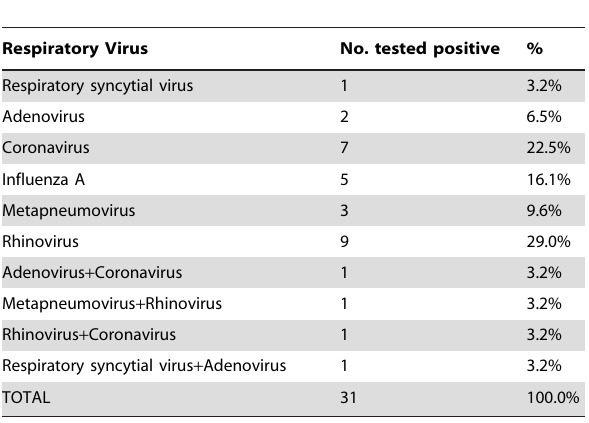
Table 4. Other respiratory viruses diagnosed by DFA and/or PCR/real time